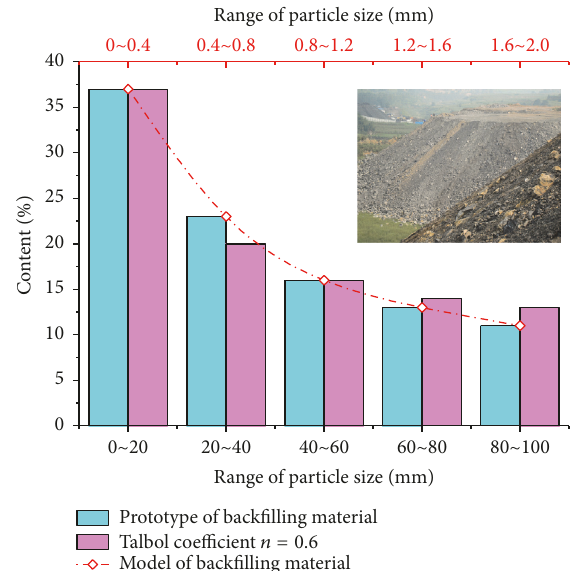
Figure 6: Particle size distribution characteristics of backfilling granular